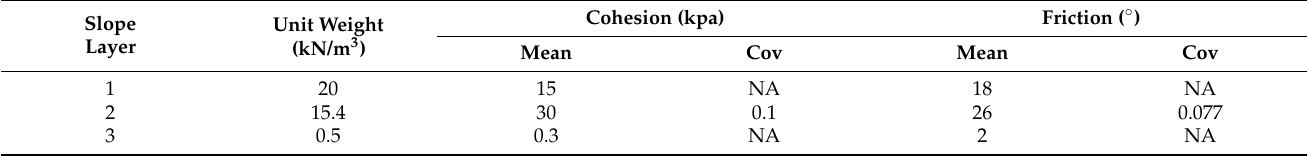
Table 7. Statistical properties of soil parameters for Dangchuan